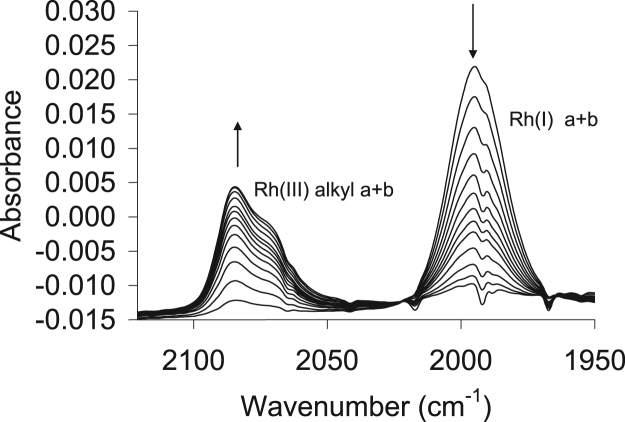
Oxidative addition of CH3I to the rhodium complex, Rh(H3CCOCHCOCH3)CO(C6H5OPPh2), 4, (shown as an example) monitored by infrared in chloroform at 25 °C. The change in vibration height (at 1995 and 2085 cm−1) vs time was used to determine kobs.